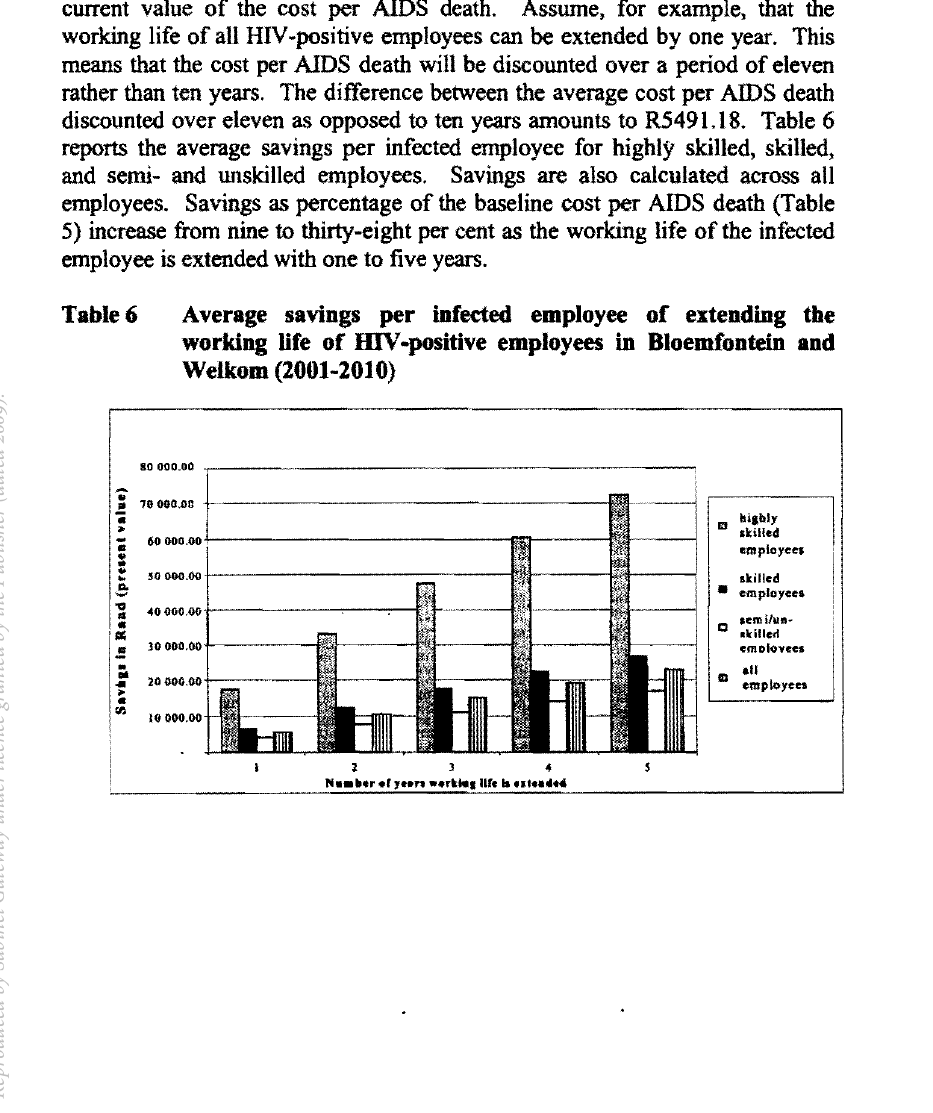
Average savings per infected employee of extending tbe working life of mv -positive employees in Bloemfontein and Welkom